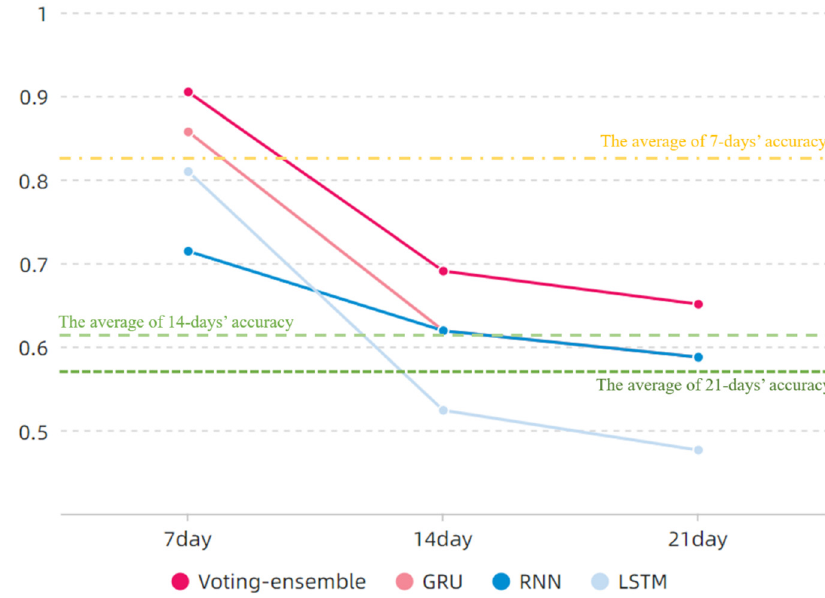
Figure 19. Correct rates of RNN, GRU, LSTM, and the proposed method.